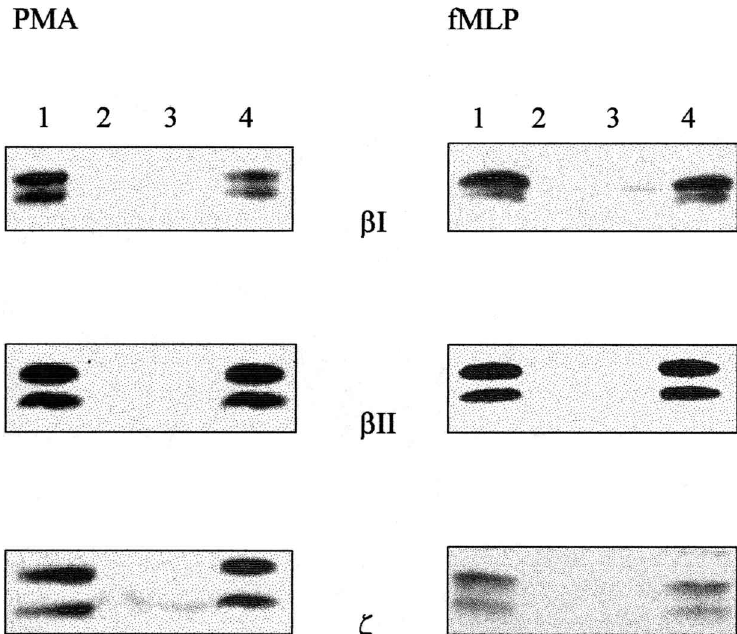
FIG. 1. For the reference, cells were incubated for the same length of time for each activator, then cytoplasm (lane 1) and plasmic membrane (lane 2) were separated by centrifugation. For the activated cells, stimulation was made by 160nM PMA for 5min or by 1 m M fMLP for 10min. After centrifugation, the cytoplasm (lane 3) was separated from the plasmic membrane (lane 4). Results are representative of three